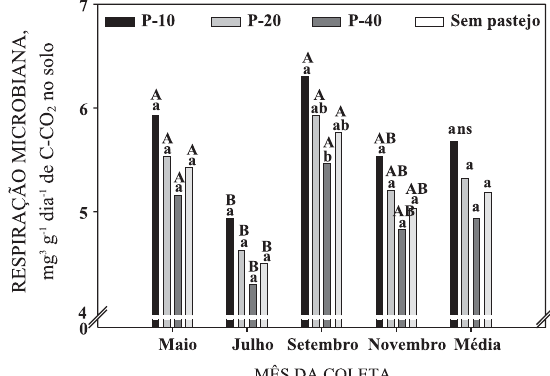
Figura 3. Respiração da biomassa microbiana do solo no ciclo de pastejo, na camada de 0 a 10 cm, de um Latossolo Vermelho em sistema de integração lavoura-pecuária submetido a intensidades de pastejo sob plantio direto. P-10, P-20 e P-40 representam as alturas de 10, 20 e 40 cm, respectivamente. Letras minúsculas comparam as intensidades de pastejo dentro de cada mês de coleta. Letras maiúsculas comparam cada intensidade de pastejo entre os meses de coleta. Letras semelhantes não diferem entre si pelo teste de Tukey a 5 %. ns: não significativo.